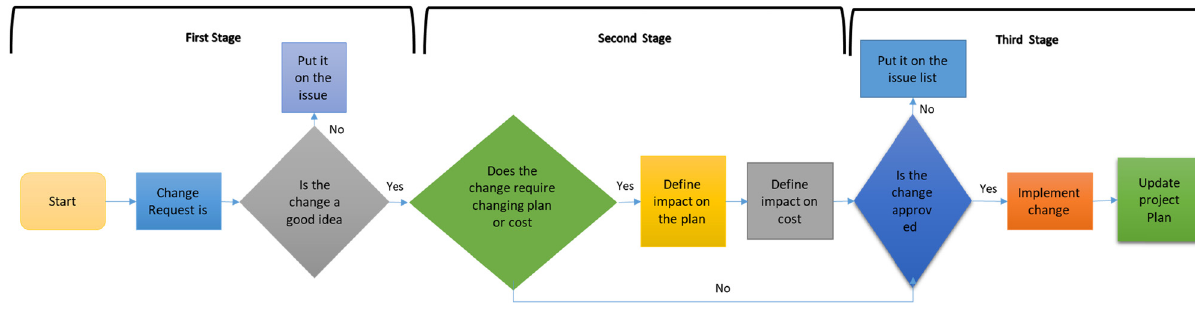
Figure 2: Flow chart of the CO process.